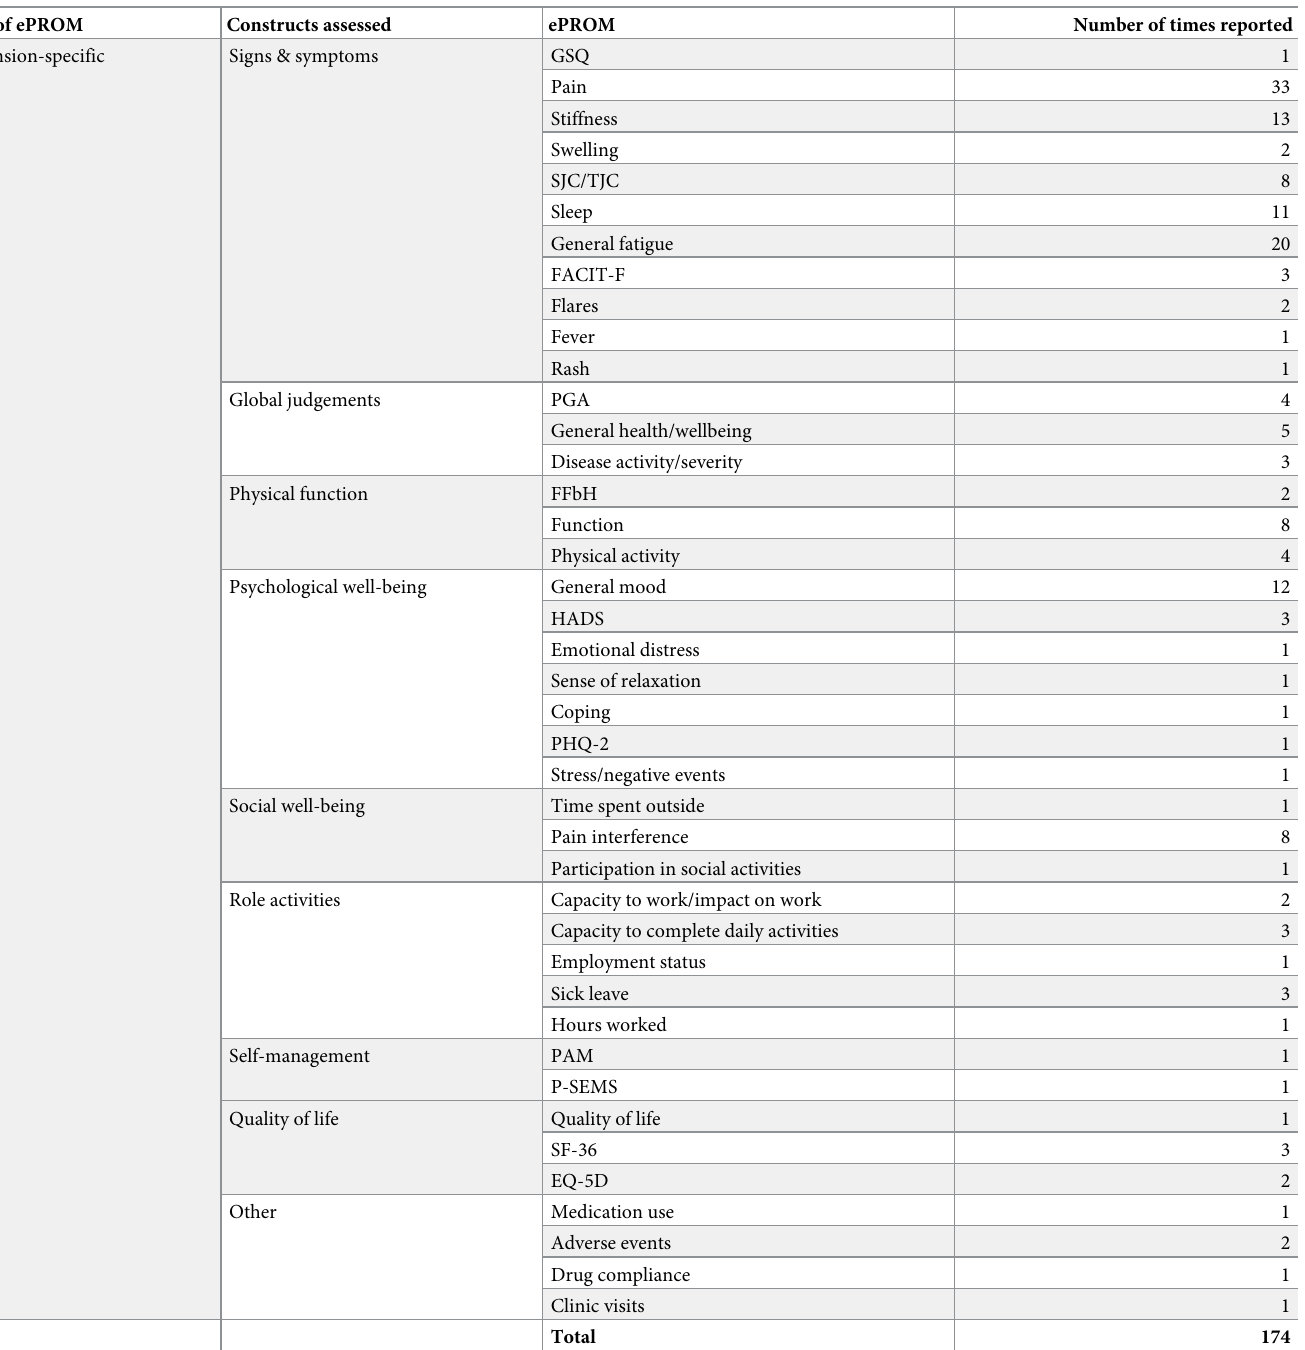
Table 1. Generic